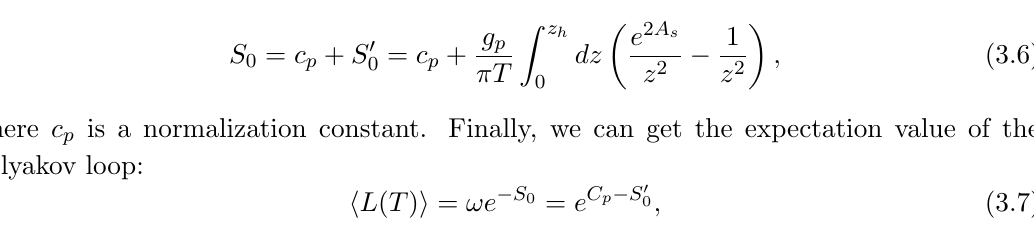
Figure 2. The expectation value of the Polyakov loop < L > (a) and its derivative d<L> a function of the temperature in the cases of (cid:22) = 0 (solid line) and (cid:22) = 0 : 5 GeV (dashed line),